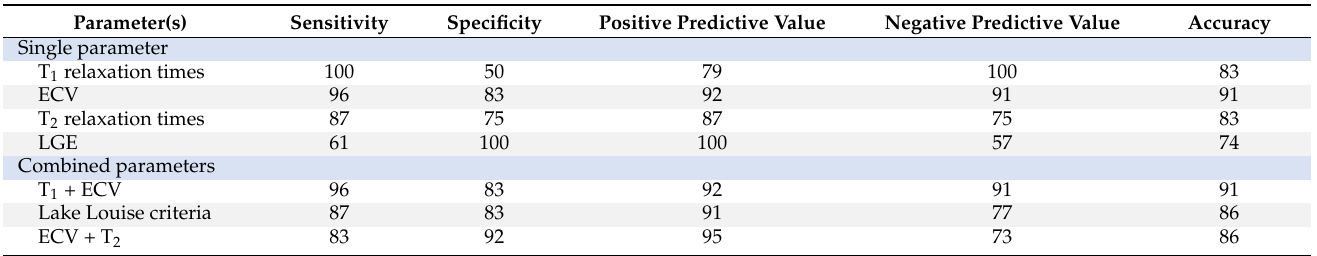
Table 3. Diagnostic Performance of CMR Criteria Combinations for Confirmation of Clinically Suspected Diagnosis of Subacute Myocarditis.